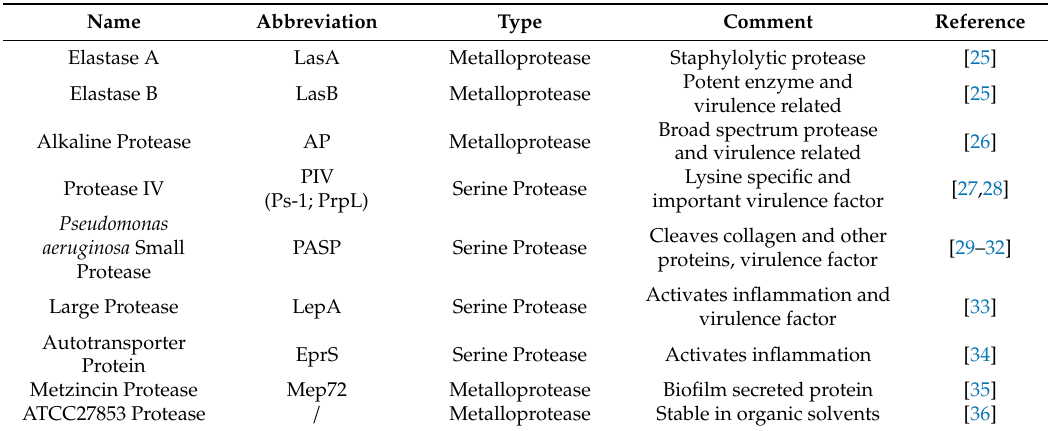
Table 1. Summary of Pseudomonas aeruginosa secreted